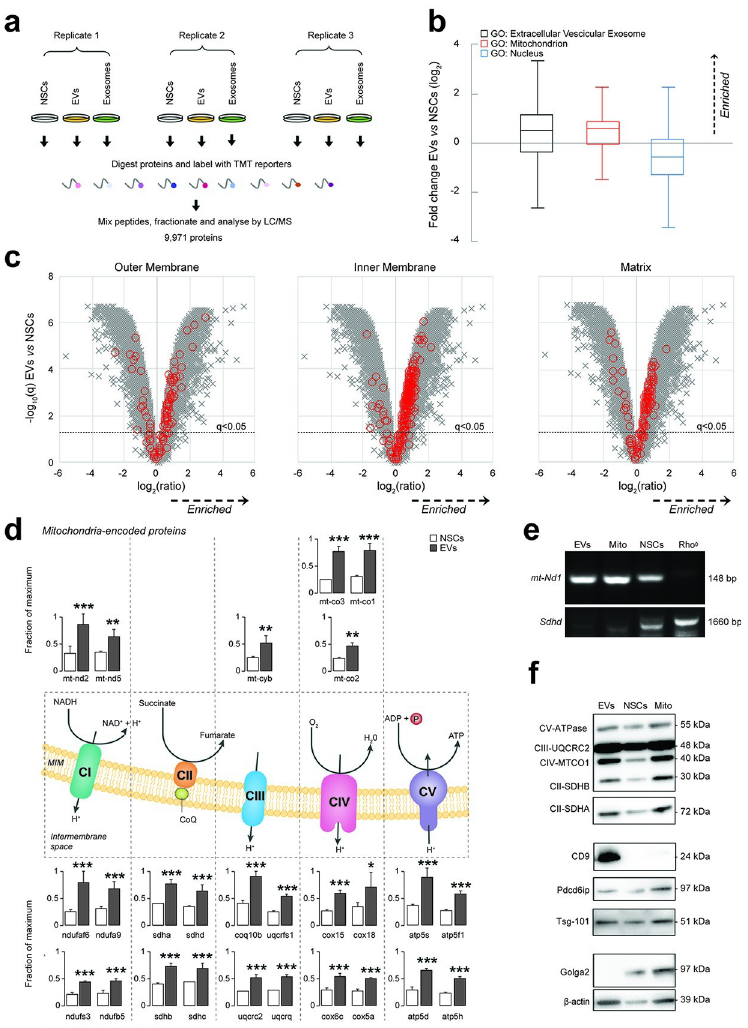
Fig 1. NSCs shed mitochondrial proteins and mtDNA via EVs. (a) Overview of multiplex TMT-based proteomic experiment. TMT-based proteomics identified a total of 9,971 proteins, of which 9,951 were quantitated across all conditions. (b) Relative abundance of proteins annotated with indicated GOCC subcellular localisations in EVs compared with NSC whole-cell lysates (NSCs). Annotations were available for 9,049/9,971 cellular proteins identified in the multiplex TMT-based functional proteomic experiment illustrated in a. Boxplots show median, interquartile range, and Tukey whiskers for proteins with the following annotations: extracellular vesicular exosome (GO:0070062, black outline, enriched in EVs); mitochondrion (GO:0005739, red outline, enriched in EVs); and nucleus (GO:0005634, blue outline, depleted in EVs). Data are from N = 3 independent biological replicates. (Data available on ProteomeXchange, identifier PXD024368, and in S3 Data). (c) Relative abundance of proteins from different mitochondrial compartments (outer membrane, matrix, and inner membrane) in EVs compared with NSCs. Volcano plots show statistical significance ( y axis) vs. fold change ( x axis) for 9,951/9,971 cellular proteins quantitated across all 3 biological replicates (no missing values) in the multiplex TMT-based functional proteomic experiment illustrated in a. Proteins annotated with the following GOCC subcellular localisations are highlighted in red: mitochondrial outer membrane (GO:0005741, enriched in EVs); mitochondrial inner membrane (GO: 0005743, enriched in EVs); and mitochondrial matrix (GO:0005759, enriched in EVs). An FDR threshold of 5% is indicated (proteins with Benjamini– Hochberg FDR-adjusted p -values (q values) < 0.05). (Data available on ProteomeXchange, identifier PXD024368, and in S3 Data). (d) Relative abundance of selected mitochondrial proteins in EVs compared with NSCs. Mitochondrial complex (C) proteins enriched in EVs and encoded in the mitochondrial (upper panel) or nuclear (lower panel) genomes in the multiplex TMT-based functional proteomic experiment include: NADH:ubiquinone oxidoreductase or CI [mtnd2 (ND2 subunit), mtnd5 (ND5 subunit), ndufaf6 (assembly factor 6), ndufa9 (subunit A9), ndufs3 (core subunit S3), ndufb5 (1 beta subcomplex subunit 5)], succinate dehydrogenase or CII [Sdha (Subunit A), sdhd (cytochrome b small subunit), sdhb (iron-sulfur subunit), sdhc (cytochrome b560 subunit)], cytochrome b-c1 or CIII